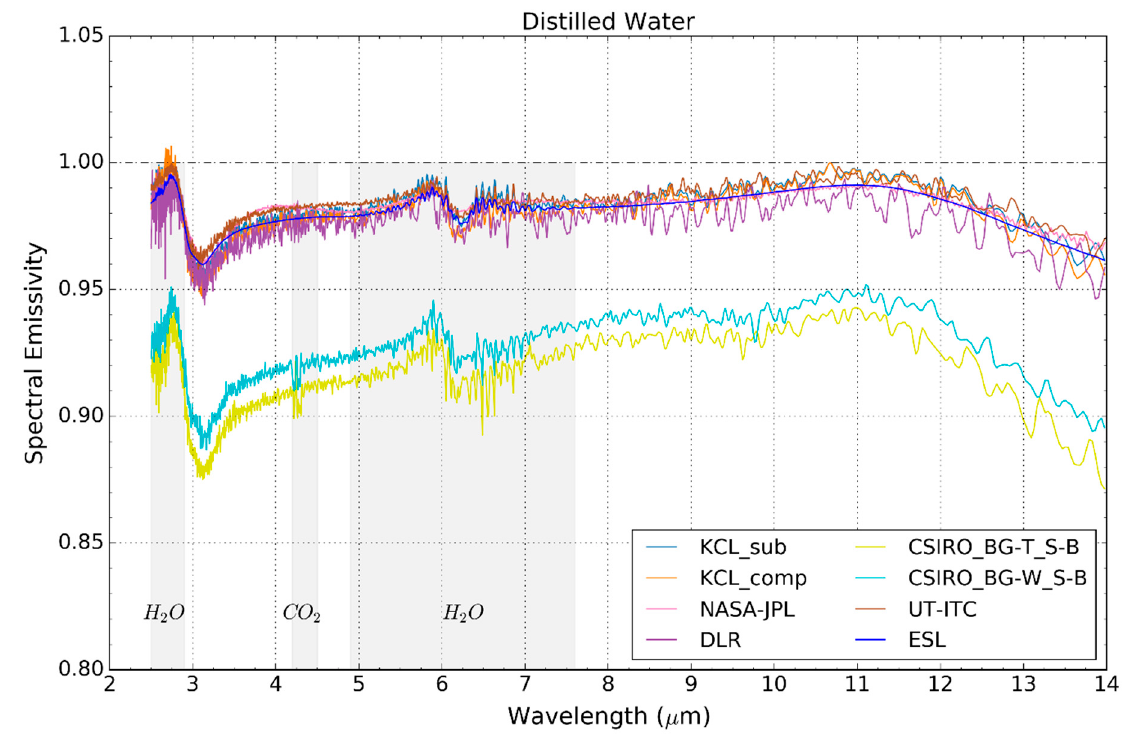
thermal band locations are also shown in green, red and blue respectively. The absorption bands of relevant gases (H 2 O and CO 2 ) are indicated through the grey vertical bars. For legend abbreviations see Table 2.